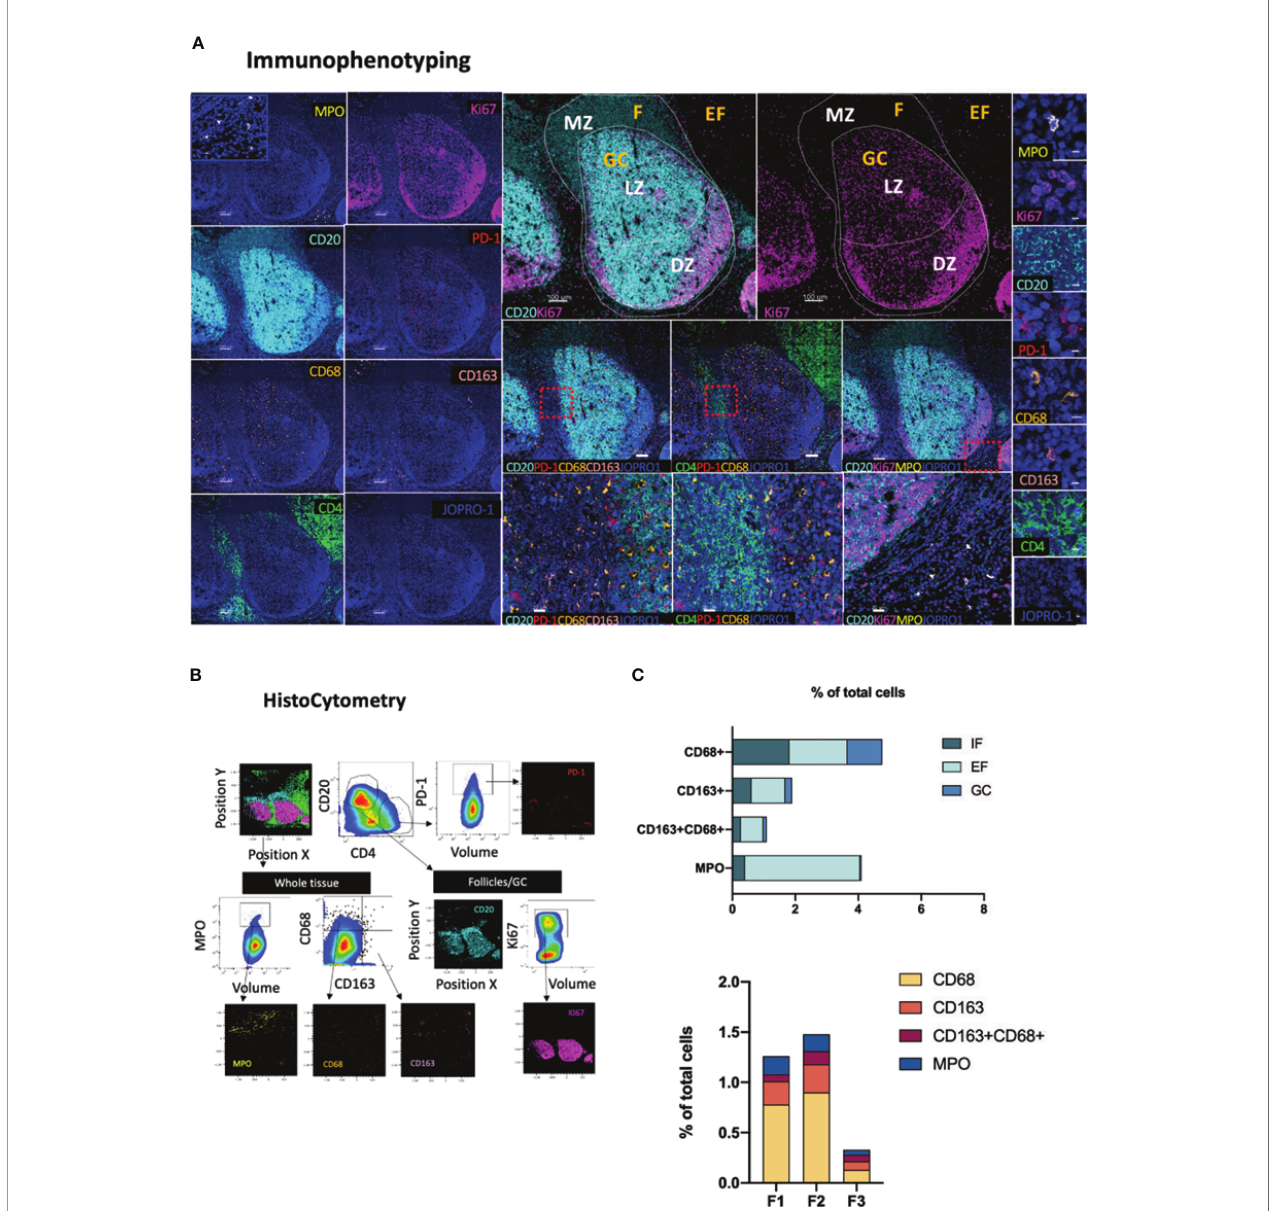
FIGURE 5 | Development of a multispectral panel for the topological examination of monocytes and in fl ammatory markers. (A) Representative example of antibody staining patterns for MPO (yellow), CD20 (cyan), Ki67 (magenta), PD-1 (red), CD68 (orange), CD163 (pink), CD4 (green) and JOPRO (nucleus, blue) and distribution of each protein marker with respect to the MZ, LZ and DZ (middle panels). Red dotted enclosures in lower middle panels denote the areas for which zoom ins are given (lower middle panels). (B) Gating strategy used for the immunophenotyping of neutrophils (MPOhi), monocytic populations (CD163 hi CD68 lo , CD68 hi CD163 lo , CD68 hi CD163 hi ) and Tfh (CD4+PD-1 hi ) in GC (CD20 dim Ki67 hi ), F (CD20 hi/dim ) and EF (CD20 lo ) areas. (C) Bar graphs showing the relative frequencies of MPO hi and various monocytic populations in intrafollicular (IF), EF and GCs as well as the frequencies of the same populations in three distinct follicles imaged. Images were acquired at 40x (NA 1.3) with 1% magni fi cation. Scale bars are 100um for all panels displaying an entire follicle), 20um in the middle panel close ups and 5um in the right panel single staining close